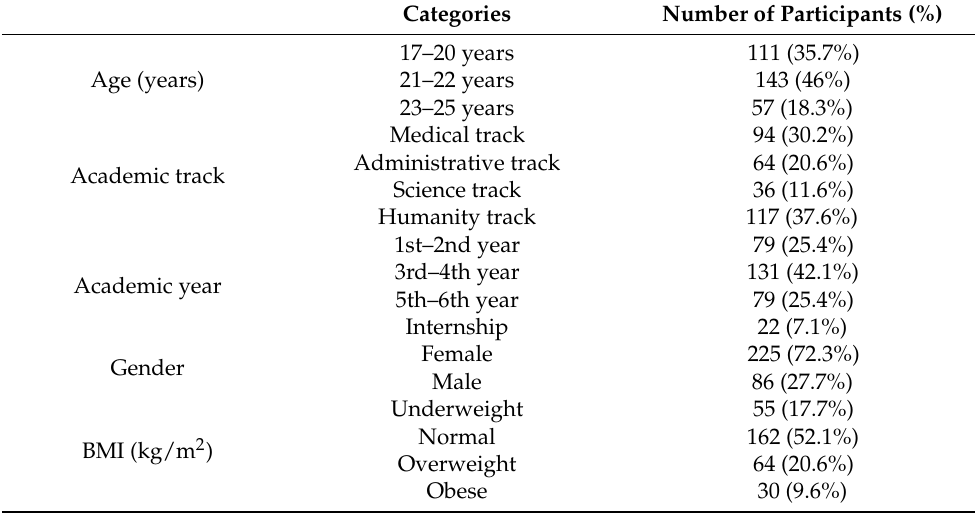
Table 1. Demographic characteristics of the students’